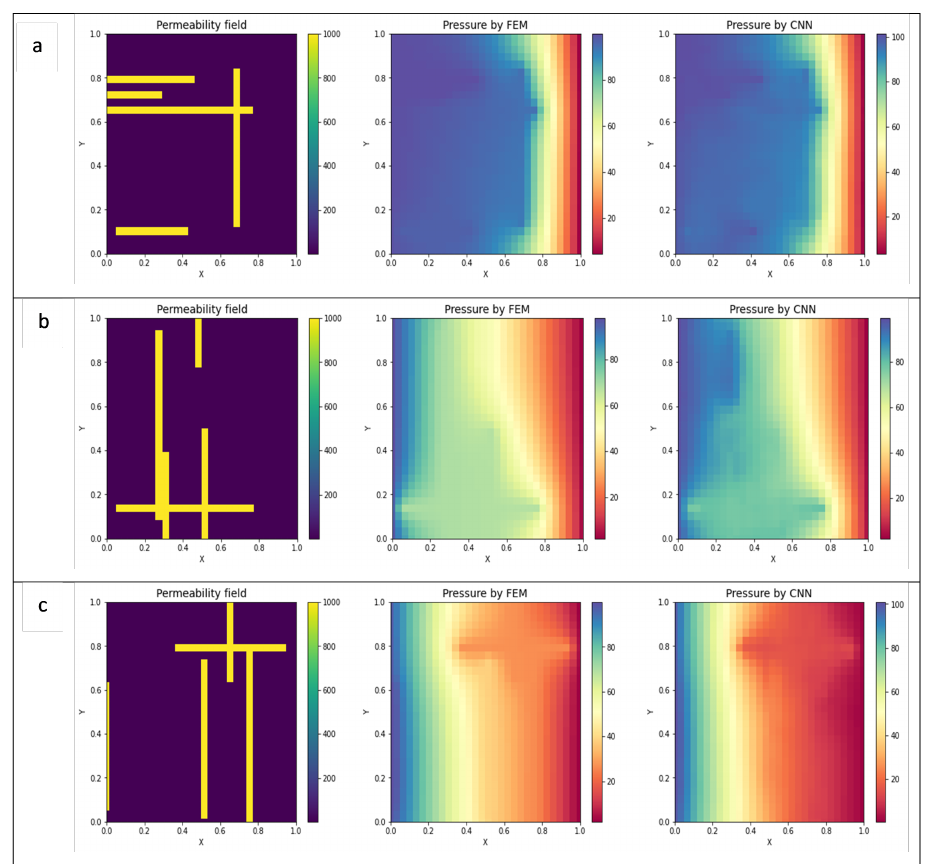
Figure 4. A comparison between the actual pressure distributions and those obtained by the skip connection-based CNN models: ( a ) training sample, ( b ) validation sample, and ( c ) testing